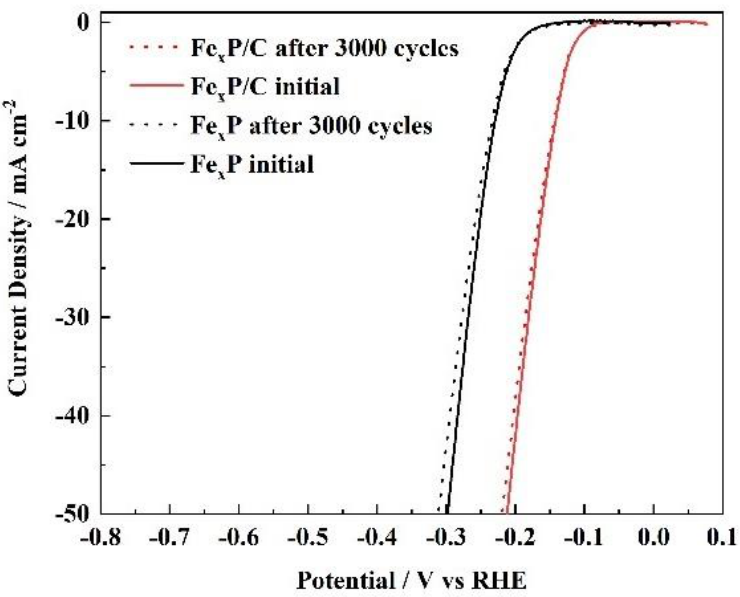
Figure 6. Comparison of the initial LSV curve (red, solid line) and the LSV curve after 3000 CV cycles (red, dashed line) for Fe x P/C, and comparison of the initial LSV curve (black, solid line) and the LSV curve after 3000 CV cycles (black, dashed line) for Fe x